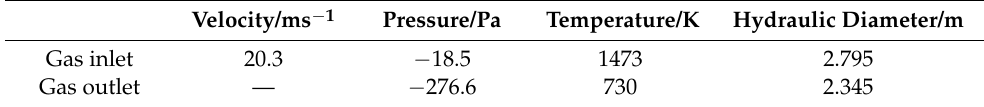
Table 2. Summaries of inlet and outlet boundary